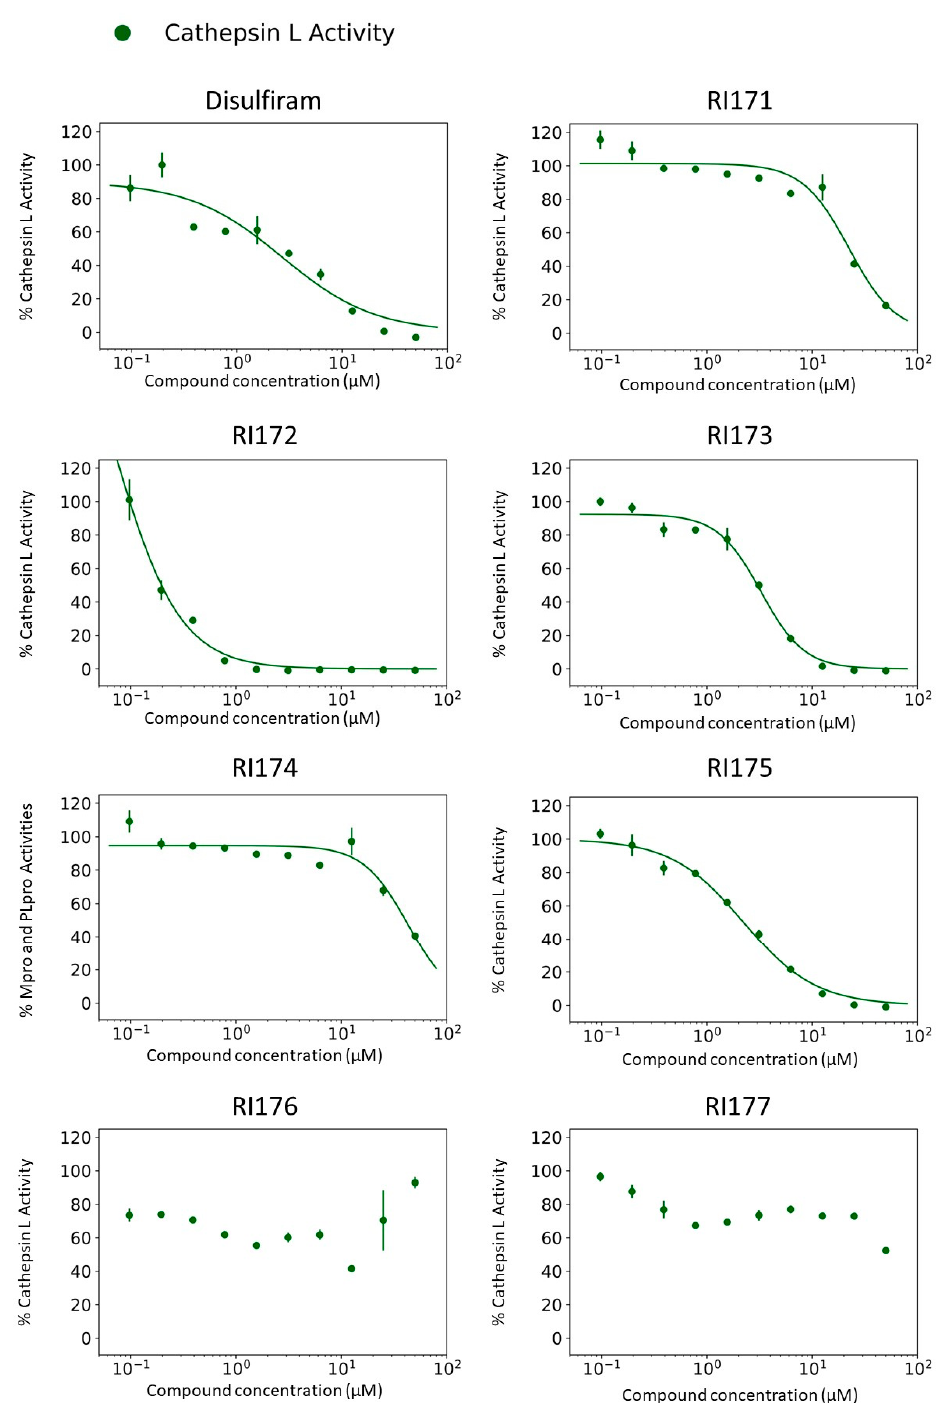
Figure 4. Thiuram disulfide or dithiobis-(thioformate) analogues inhibit human cathepsin L. Dose– response curves of newly identified dual viral protease inhibitors disulfiram, RI171, RI172, RI173, RI174, RI175, RI176, and RI177 against human protease cathepsin L. Error bars represent the standard errors of independent three experiments. The proteolytic activities of both enzymes were deter- mined by the enzymatic fluorescence assay and shown as percent activities relative to the negative control (DMSO).